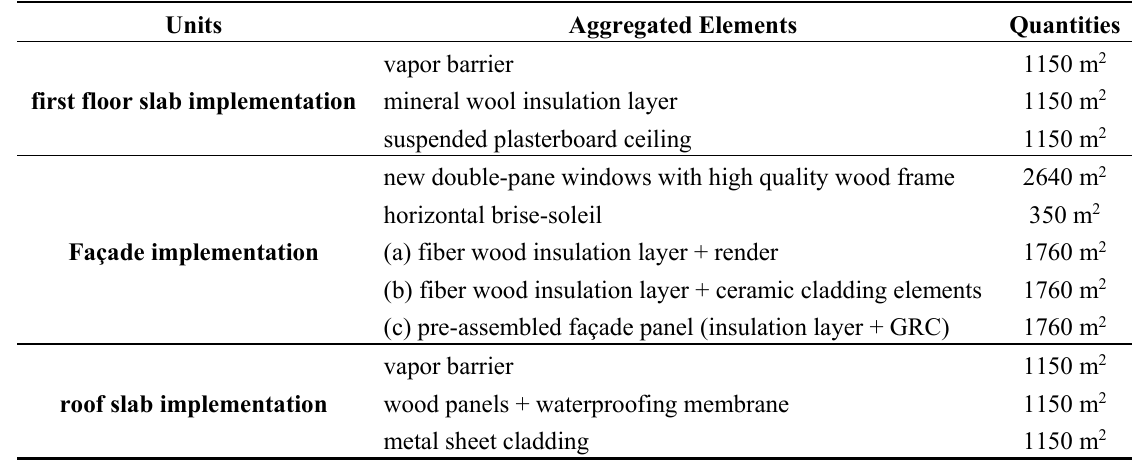
Table 4. Aggregated elements and units considered.